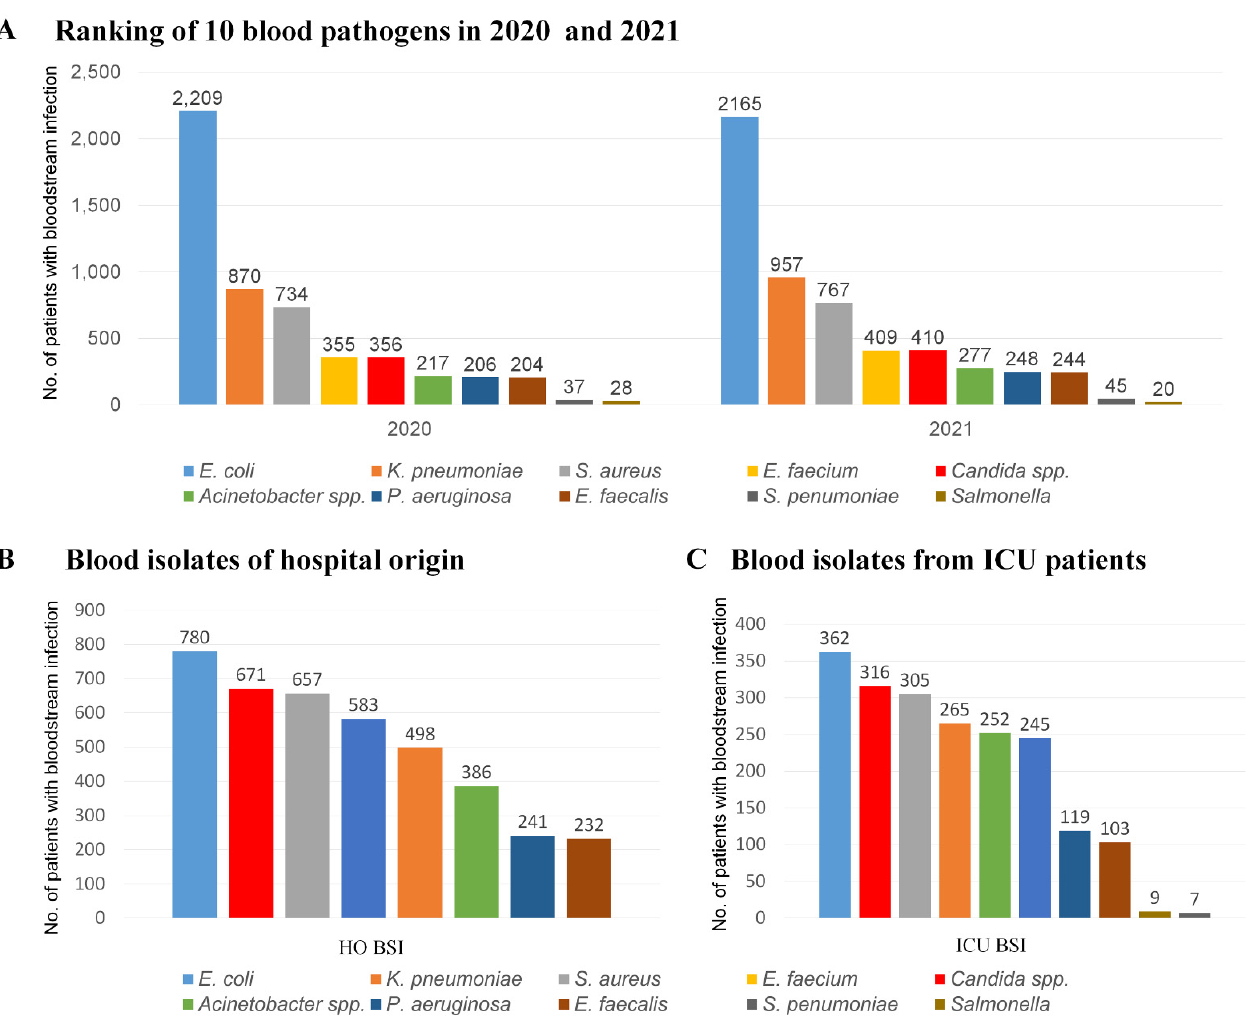
Figure 1. Number of patients with bloodstream infections (BSIs) for each target pathogen collected via the Kor-GLASS surveillance system (2010–2021). ( A ) Total number of BSIs caused by each target pathogen. ( B ) Number of hospital-origin BSIs caused by each pathogen. ( C ) Number of BSIs caused by each pathogen in ICU patients. by each pathogen in ICU